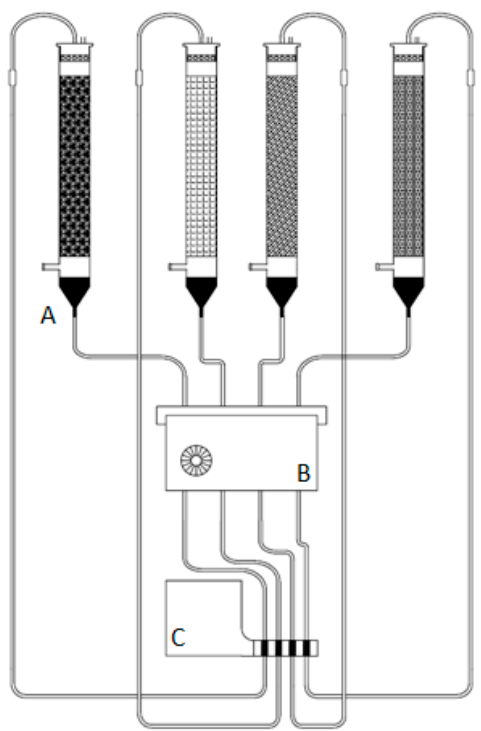
Figure 2. Experimental system: ( A ) Glass columns packed with different support materials; ( B )